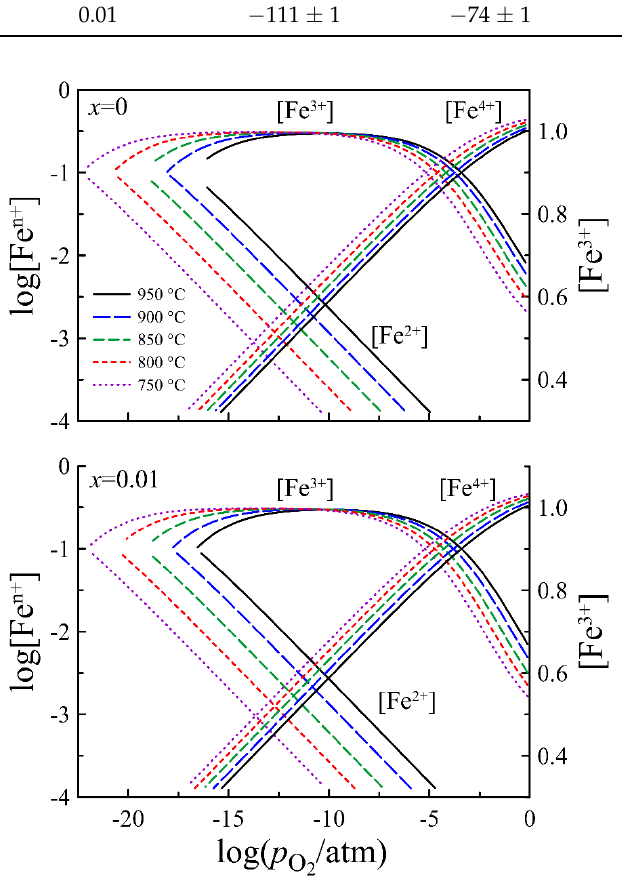
Figure 10. Concentration of iron ions in different oxidation states in La 0.5 − x Sr 0.5 FeO 3 − δ ( x = 0 and 0.01) as a function of oxygen partial pressure at different temperatures. Table 3. Thermodynamic parameters of the defect formation reactions in La 0.5 − x Sr 0.5 FeO 3 − δ . x